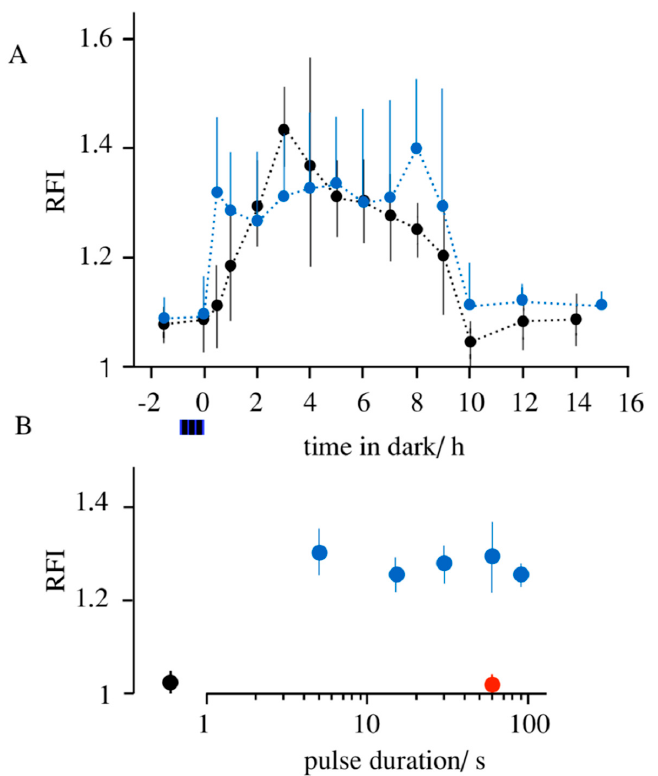
Figure 4. Expression of Kesv as a function of different light protocols. ( A ) Changes in RFI value before and after illuminating HEK293 cells transfected with independent vectors Kesv/CRY2/CIB1 (blue) or from a unified vector [ Kesv/CRY2/CIB1 ] (black). Cells were illuminated for one hour with pulsed light (10 s on/60 s off, 6 μ mol) before transferring them back to the dark. Cells were then imaged after variable times in the dark. The time of illumination and subsequent imaging was chosen such that all cells were incubated for a period of 16 h after transfection. Data are mean RFI values ± SD from 20 cells for each time point. ( B ) Changes in RFI value in response to single light pulses. HEK293 cells transfected with [ Kesv/CRY2/CIB1 ] were either kept in the dark (black symbol) or illuminated with a single blue light pulse (120 μ mol) between 5 and 1200 s or 60 s of red light pulse (120 μ mol, 660 nm) 4 h prior to imaging. In all cases, cells were incubated for a total time of 16 h post transfection. In A and B, each data point is the mean ± SD of 20 cells imaged.